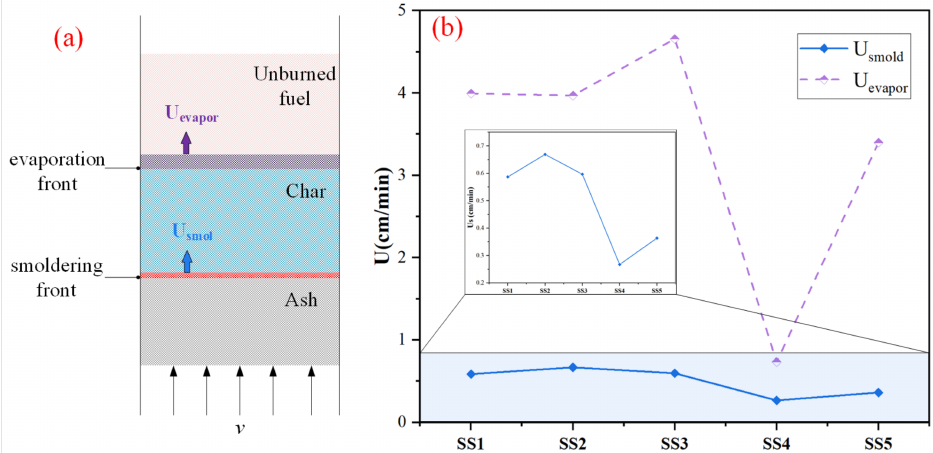
Figure 10. Smoldering front and evaporation front of various SS: ( a ) smoldering structure, ( b ) velocity curves in self-sustaining smoldering